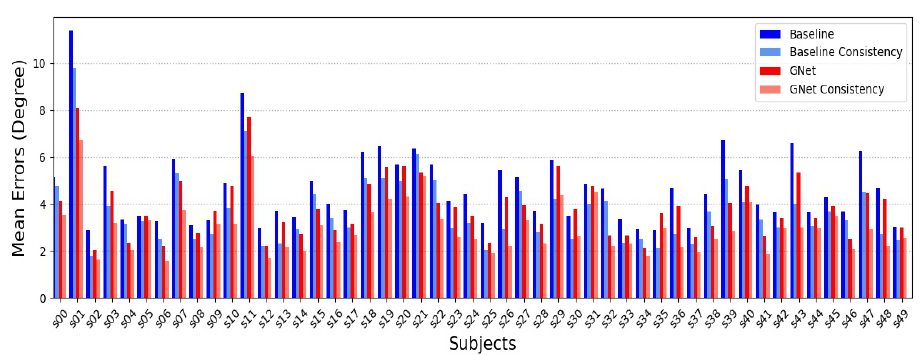
Figure 8. A comparison between the results from the baseline model and the proposed GNet model, both with and without the gaze consistency principle, for different subjects from the UT-Multiview dataset.